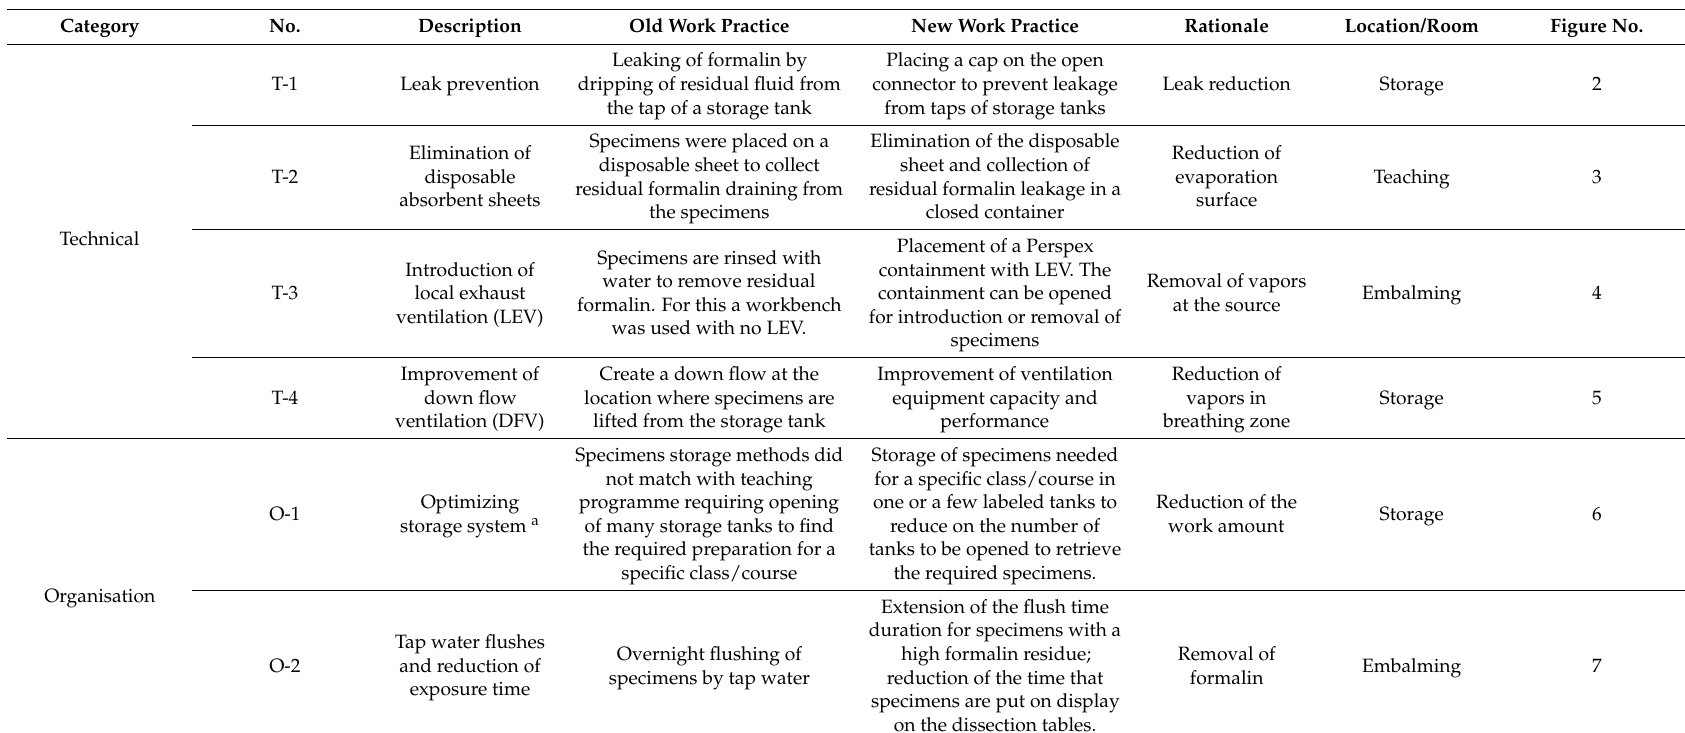
Table 2. Interventions for mitigation of exposure to FA in an anatomy